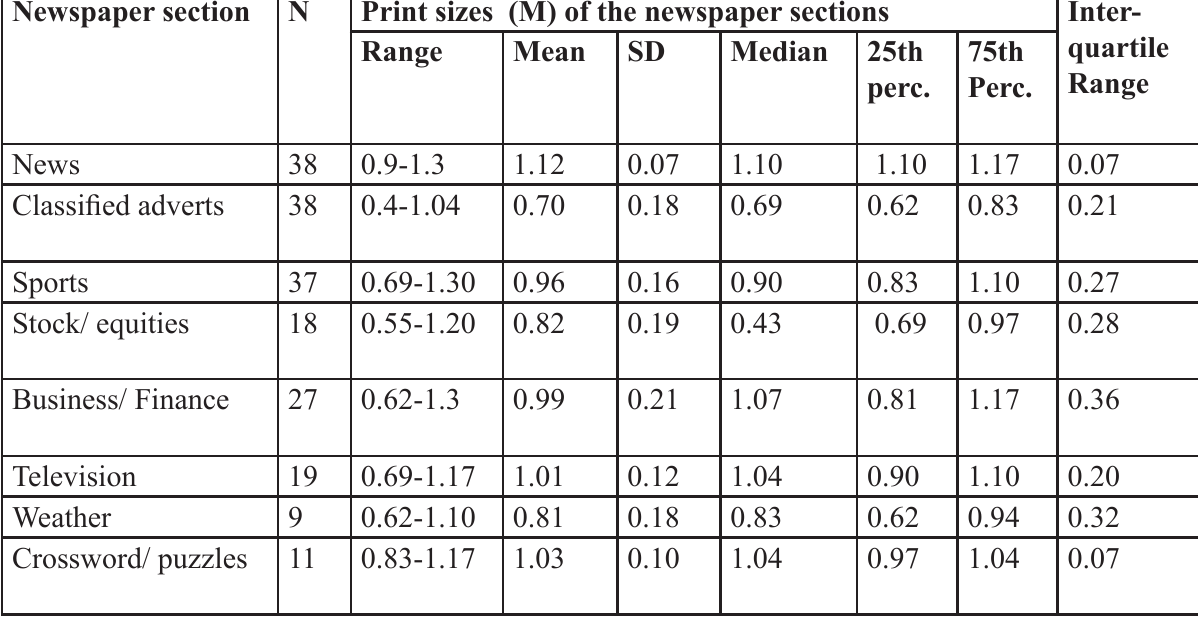
Table 1: The various sections of the newspapers measured, N is the number of newspapers which feature the sections indicated. Range, mean and standard deviation, median, 25th, 75th percentiles and inter-quarter percentiles of the print sizes in M units are shown. The mean and median values were similar except in the stock and equity sections.